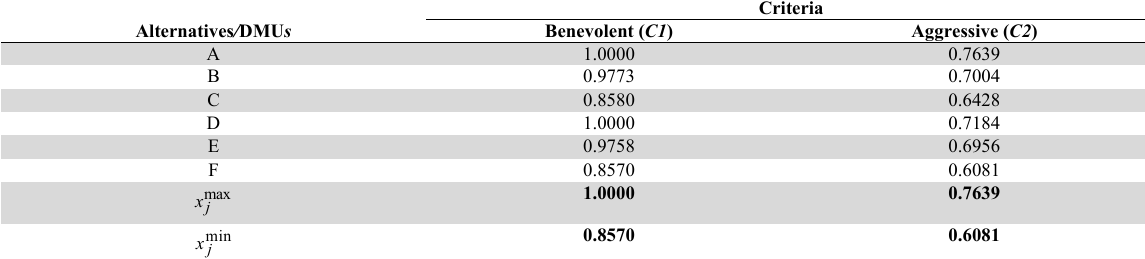
Decision matrix of six nursing homes Alternatives / DMU